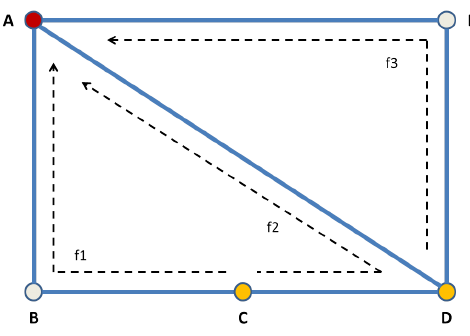
Figure 1. A simple example to describe the procedure of the algorithms proposed in this